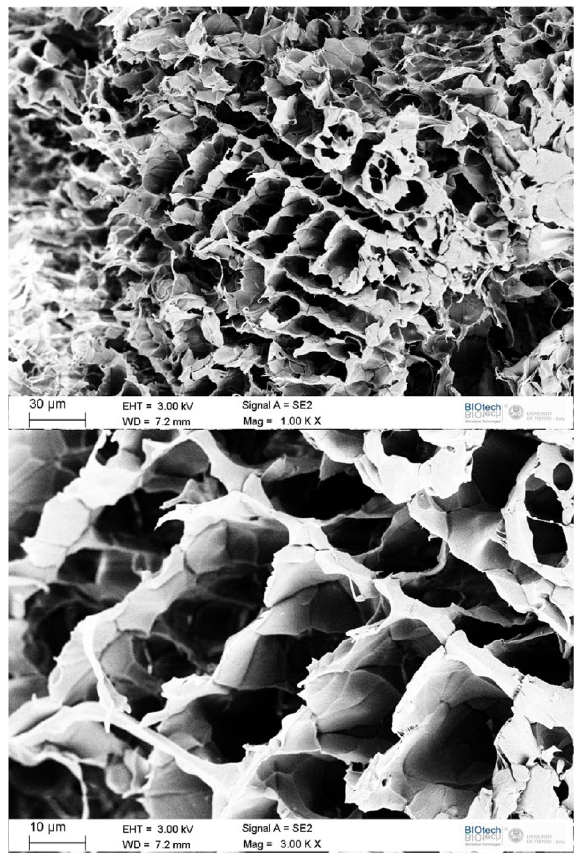
Figure 2. High magnification SEM micrograph of a sample made with 10% polypropylene showing a close-up of the ordered structure made from flakes and spine-like columns.